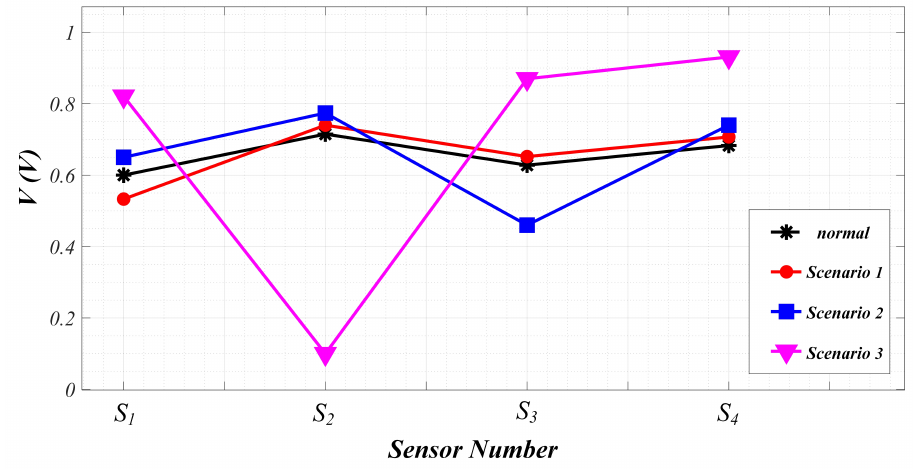
Figure 17. Sensor outputs of the normal condition and three implemented